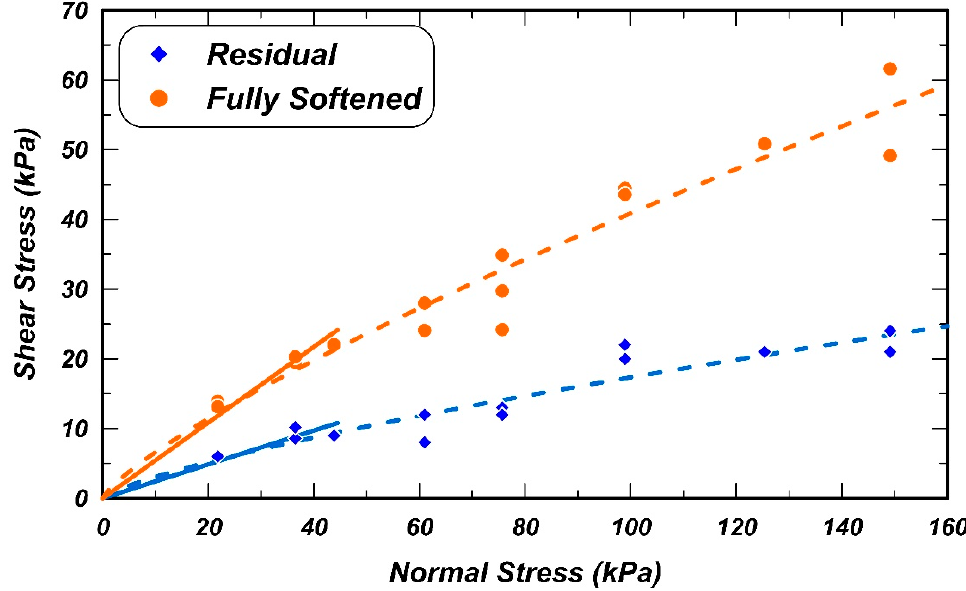
Figure 7. Saturated residual and fully softened shear strength parameters estimated by linear (solid lines) and power fits (dashed lines). lines) and power fits (dashed Table 2. Saturated shear strength envelopes.